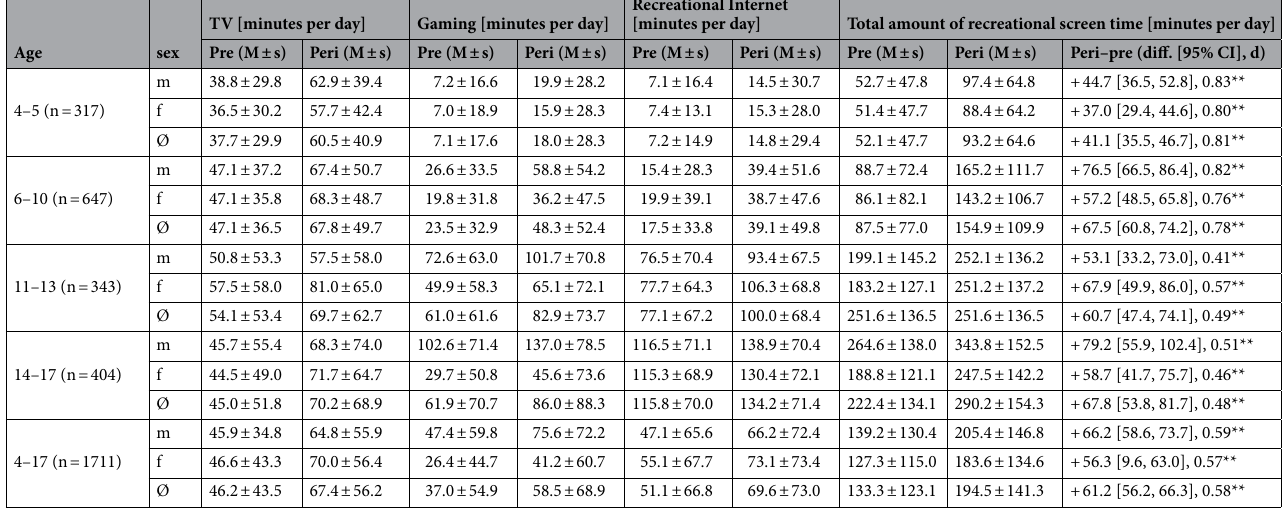
Table 4. Recreational screen time usage before and during the COVID-19 lockdown in Germany (MoMo Study). m male, f female, Ø mean of males and females, M mean, s standard deviation, 95% CI 95%